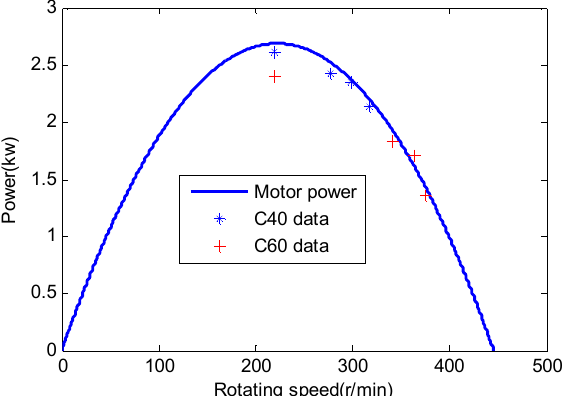
Figure 16. The power curve of the pneumatic motor after increasing the thrust of the leg.